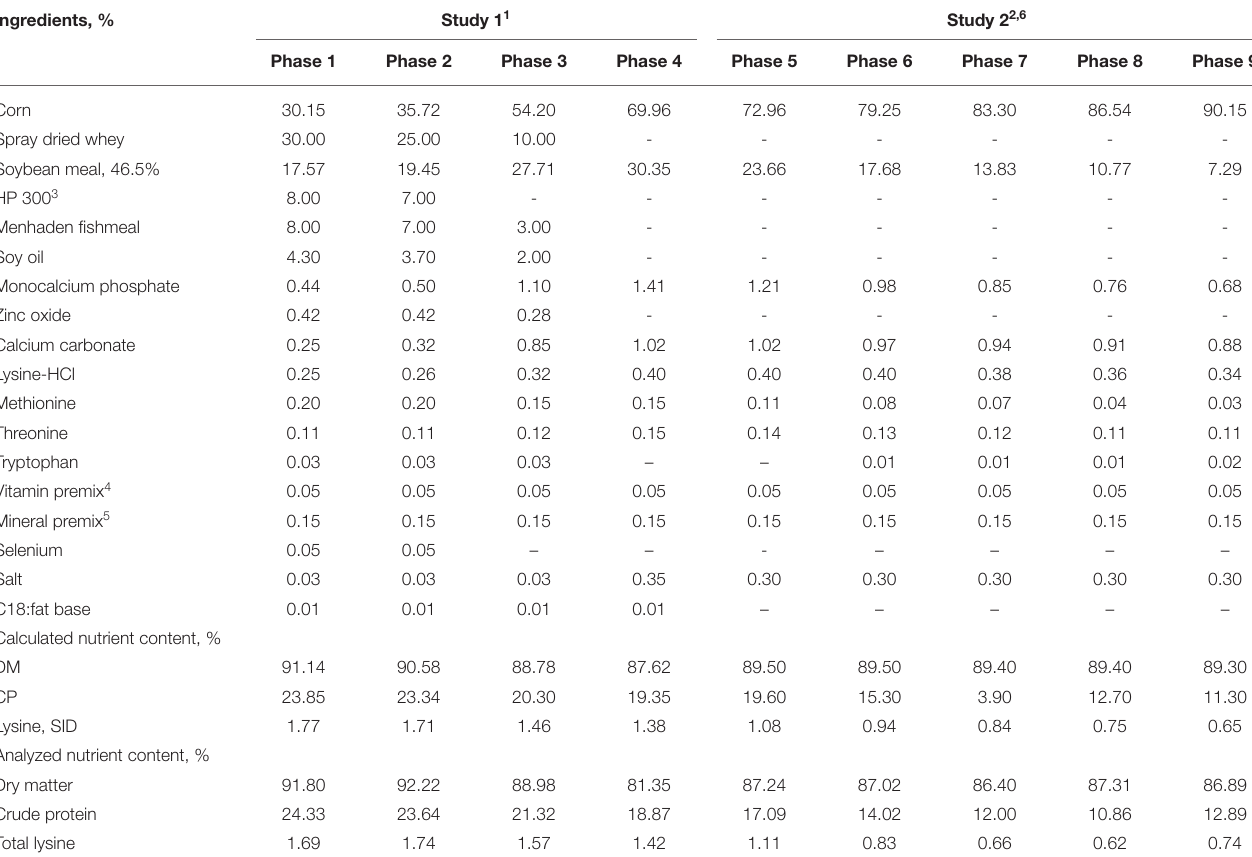
TABLE 2 | Ingredient composition and nutrient content of the control weaned pig diets in studies 1 and 2. Ingredients,